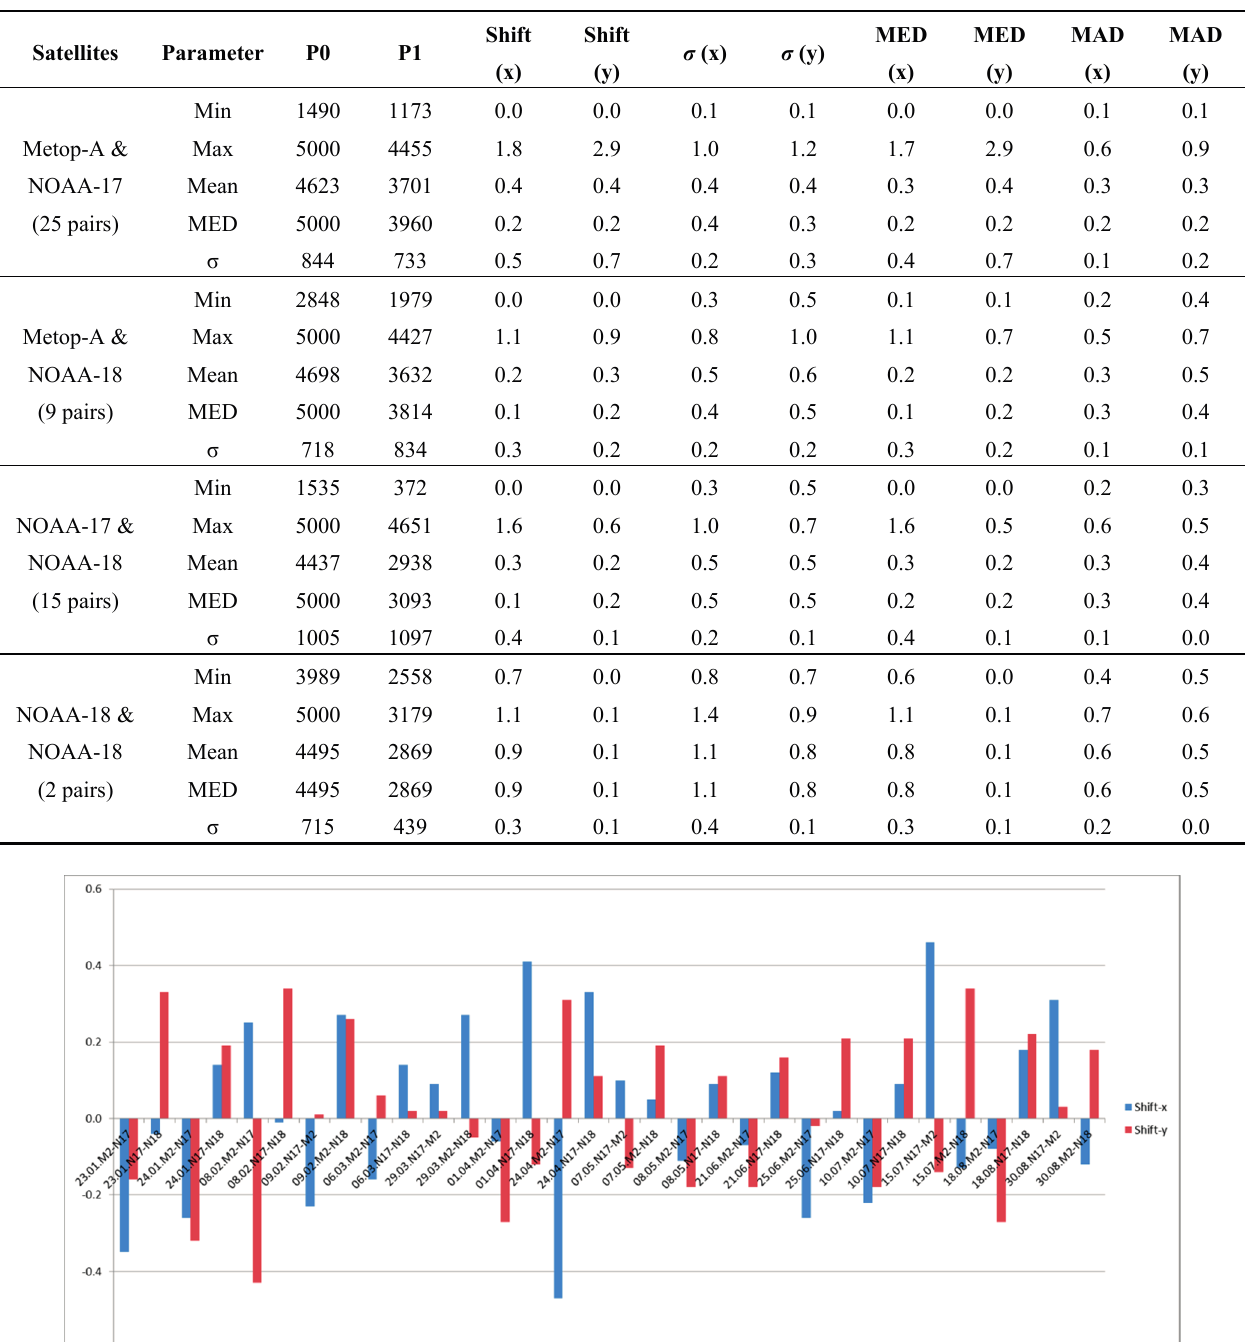
three satellites. The green dotted lines in Figure 8 denote the range of vertical axis of Figure 7 for comparison. Table 2. Relative accuracy evaluation; statistical values of shifts (x) and (y) from 51 image pairs acquired on 24 different days in 2008. All results except the number of points P0 and P1 are given in pixels and are derived from absolute values.